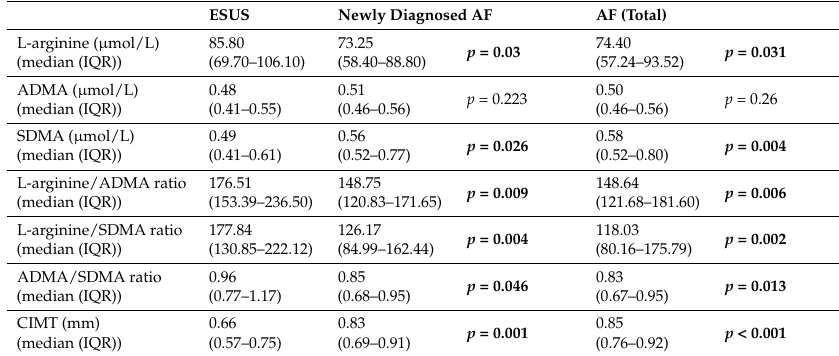
Table 2. Comparison of Dimethylarginines and Carotid Intima–Media Thickness (CIMT) between ESUS and